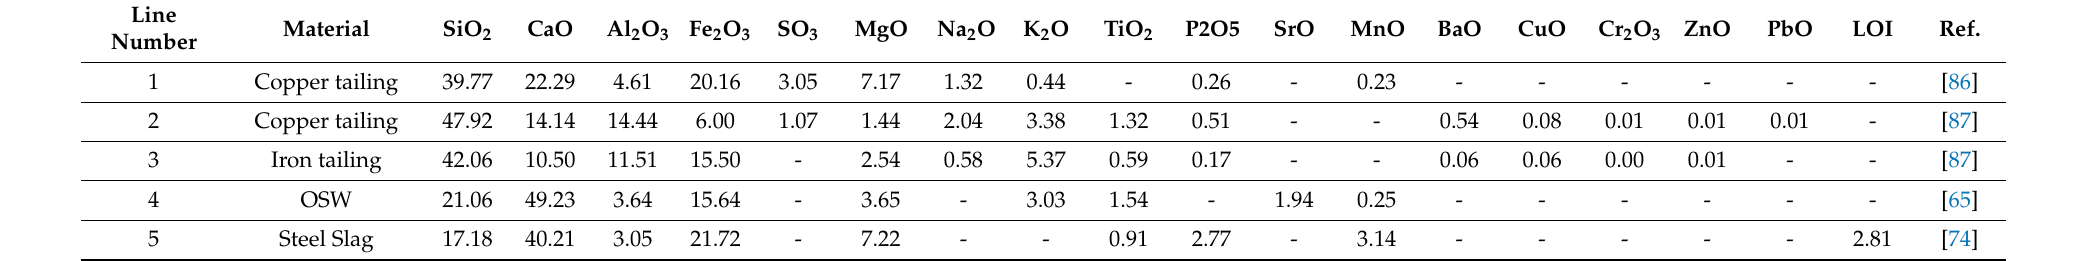
Table 8. Chemical composition of different types of waste used as aggregate in 3DPCC mixtures, excluding recycled